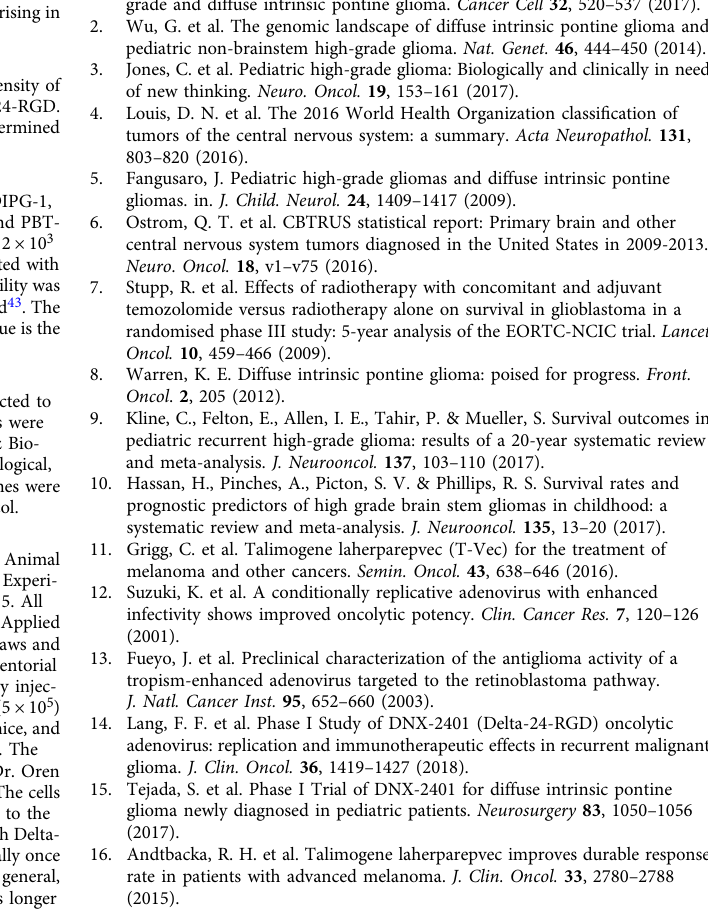
and ectopic H3.3K27M 17 . The XFM cell line was generated from a tumor arising in a mouse model driven by PDGF-B signaling and INK4A and ARF loss 18 . Viral replication assays . The pHGG and DIPG cells were seeded at a density of 2× 10 5 cells per well in six-well plates and infected with 10 MOIs of